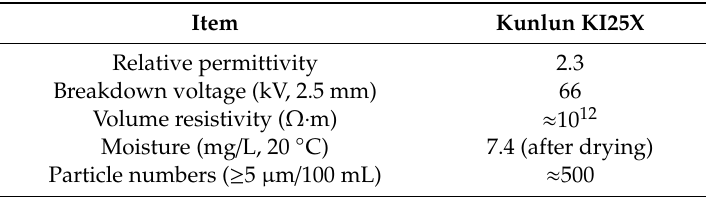
Table 1. Characteristics of the KI25X transformer